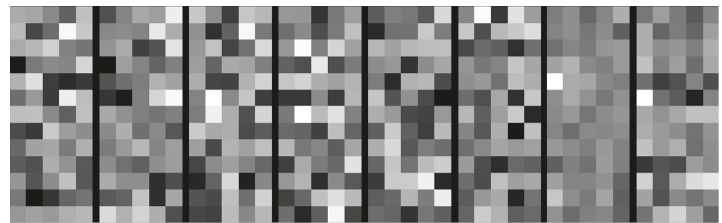
Figure 11: Coefficients of the filters in the first convolutional layer with 8 channels.